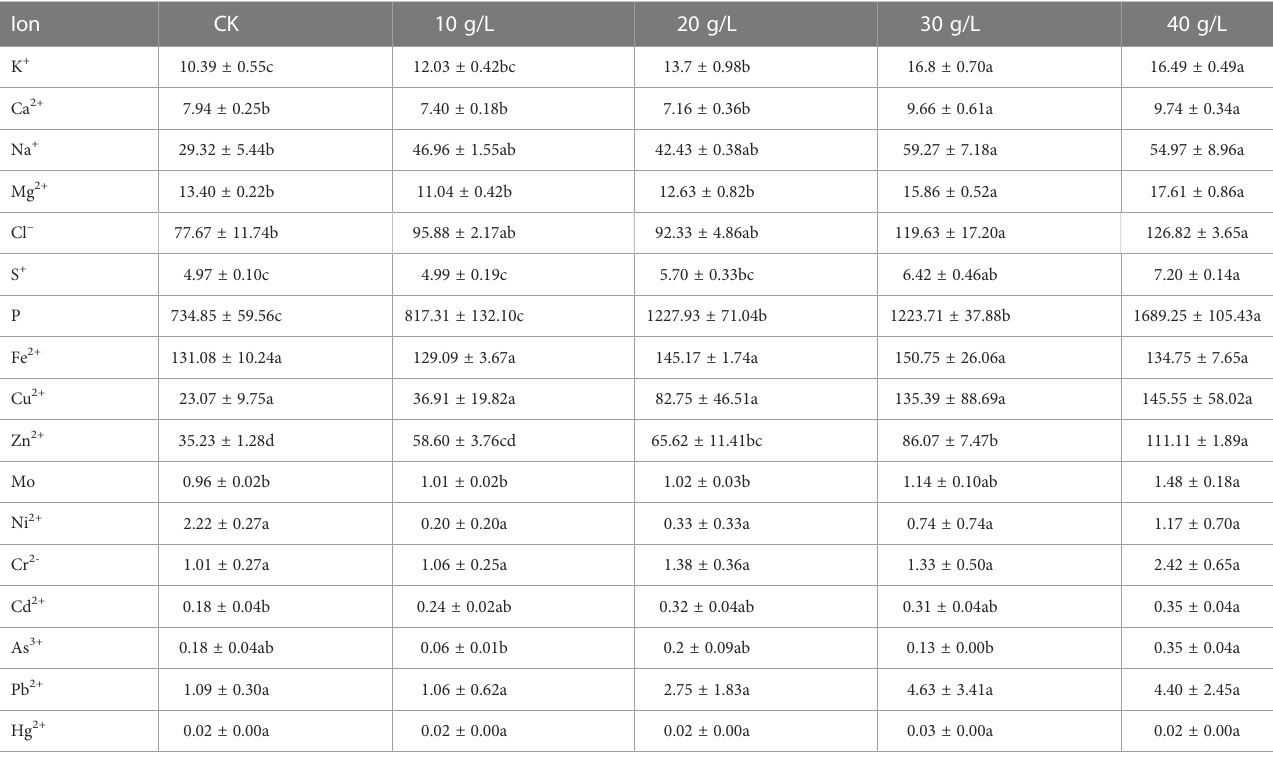
TABLE 3 Mineral and heavy metal contents of S. salsa under irrigation with water of different salinities.